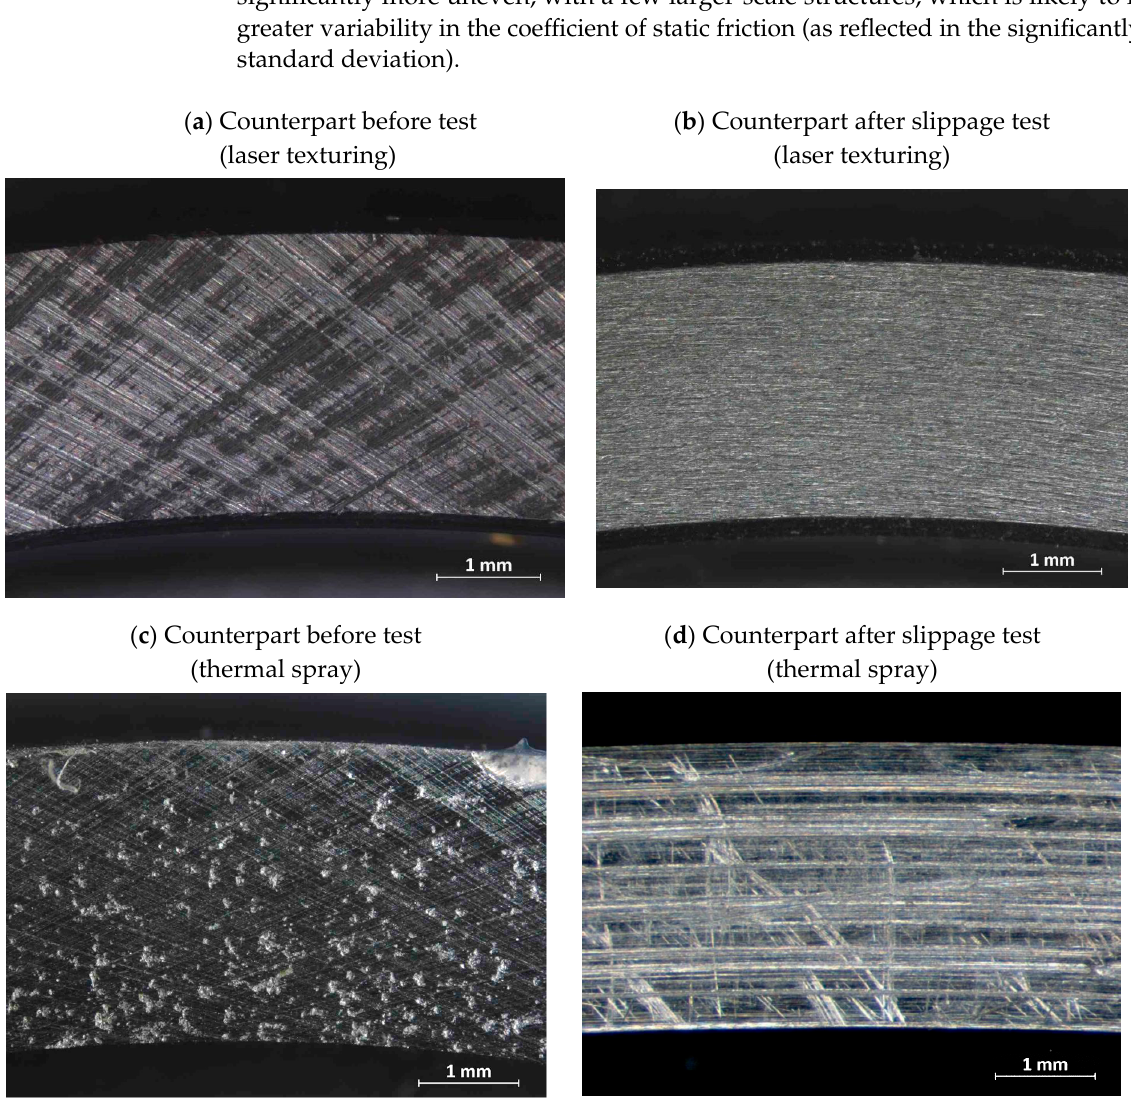
Figure 14. Images of counterparts that are in contact with the high-friction rings before and after slippage test. ( a ) Counterpart before slippage test (laser texturing)—no visible indentations by pressing of the laser textured part. ( b ) Counterpart after slippage test (laser texturing)—The surface of the counterpart after the slip test with laser- textured and hardened part exhibits a uniform surface without any dominant features. ( c ) Counterpart before slippage test (thermal spray)—The bright spots are indentations created by pressing of the thermal-sprayed part into the counterpart, indicating uneven, large structures created by the coating. ( d )—The surface of the counterpart after the sliptest with the thermal-sprayed sample exhibits large scuff marks and scratches created by the thermal-sprayed surface.